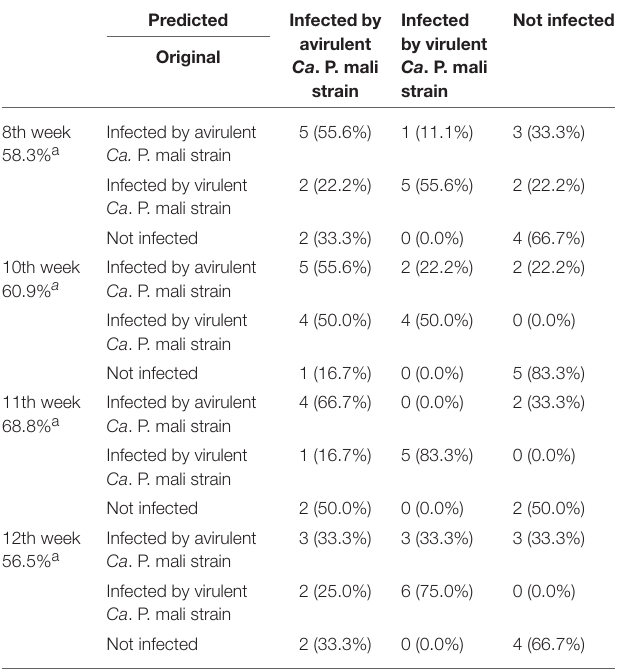
TABLE 2 | Classification table of cross validation results for group memberships of tobacco plants. Predicted Infected by Infected Not avirulent by virulent Ca . P. mali Ca . P. mali strain strain